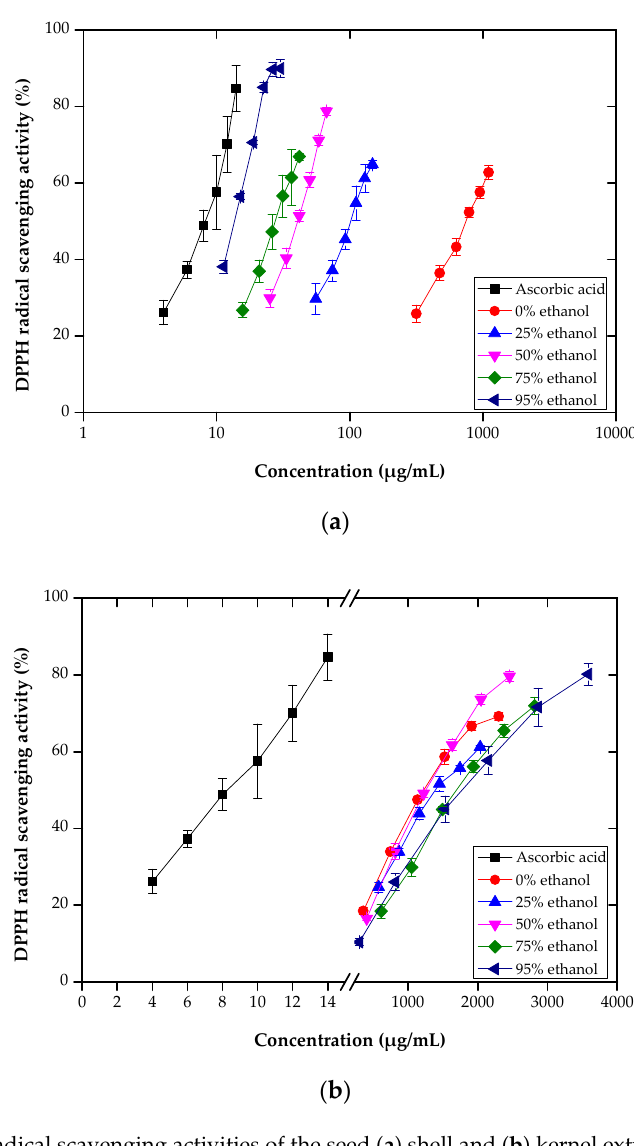
Figure 2. DPPH radical scavenging activities of the seed ( a ) shell and ( b ) kernel extracts from different ethanol solutions.